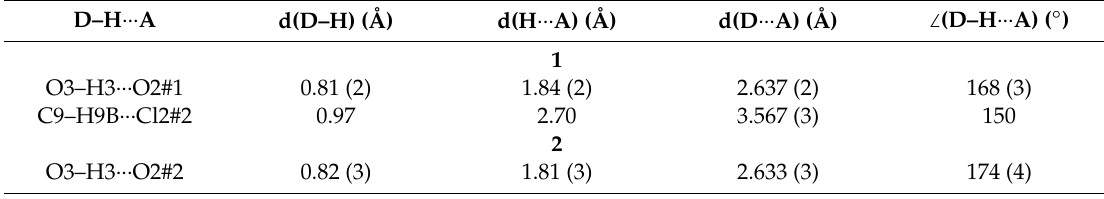
Table 3. Hydrogen bonding parameters in 1 and 2 (D, Donor atom; A, Acceptor atom) a